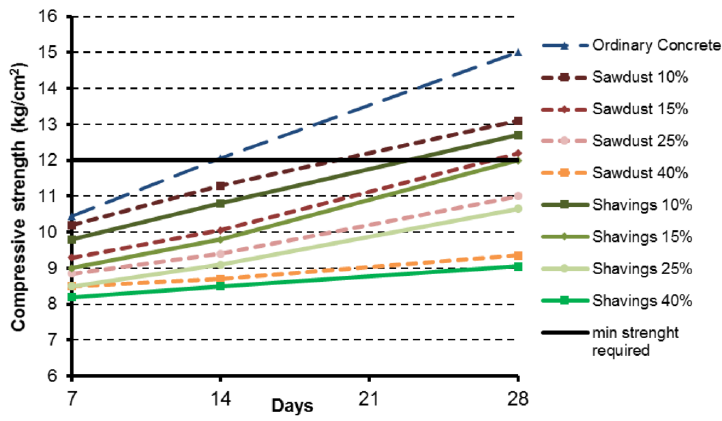
Figure 4. Daily evolution of the concrete block compressive strength.